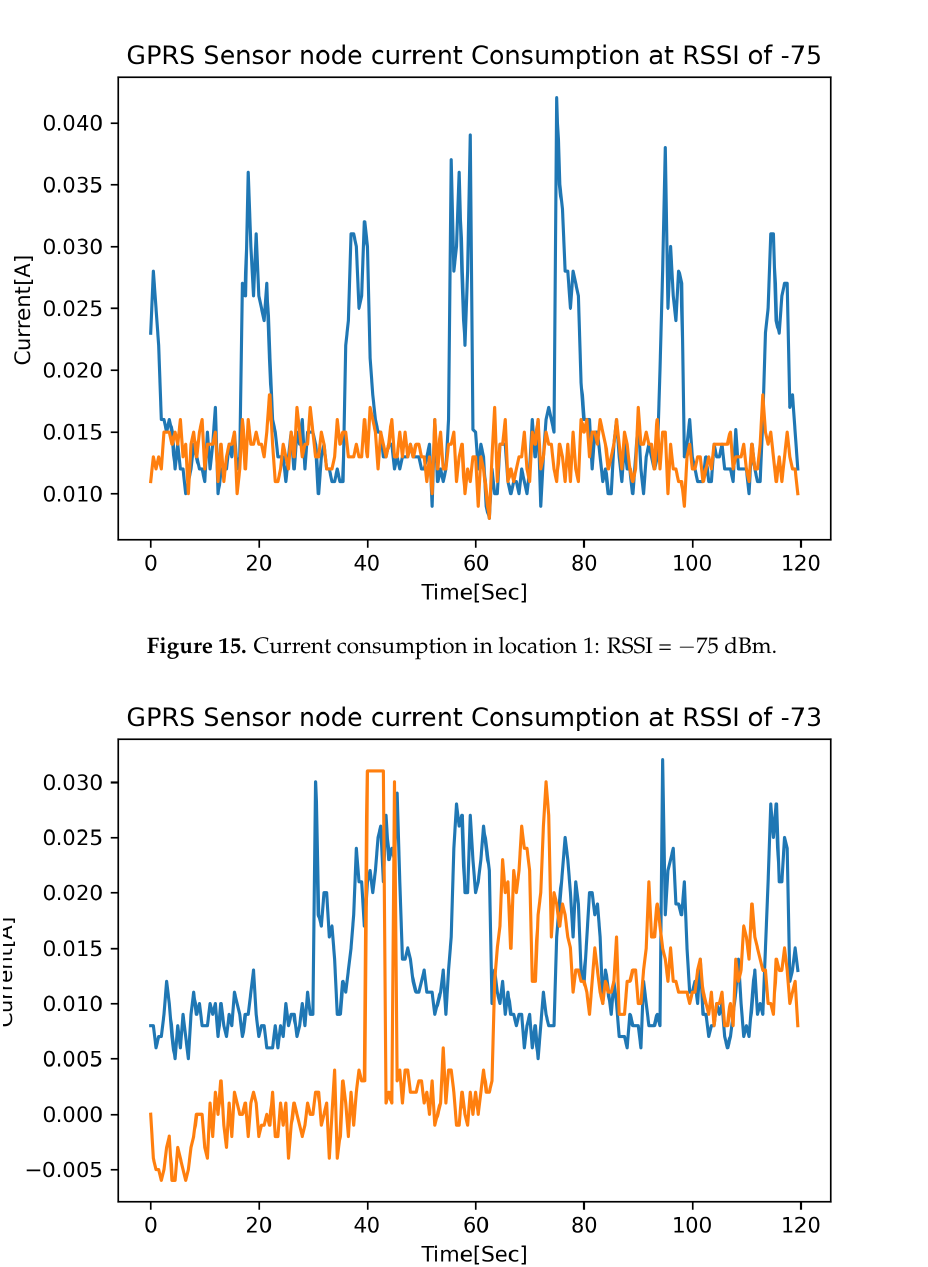
Figure 16. Current consumption in location 4: RSSI = − 73